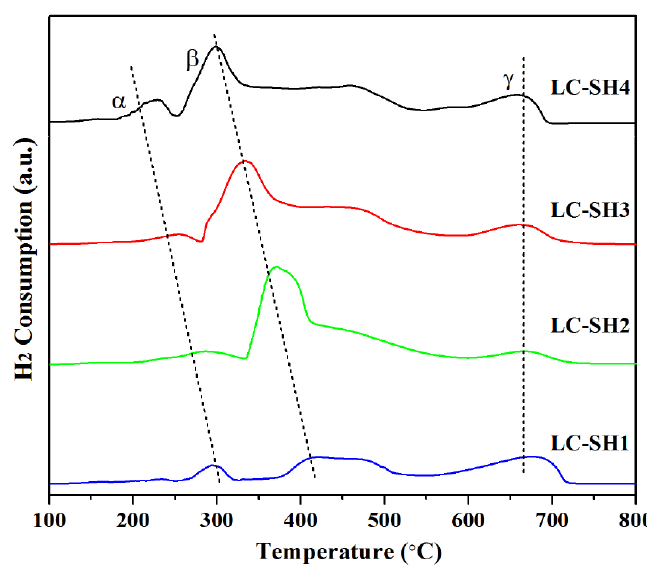
Figure 12. H 2 -TPR figures of catalysts with different amounts of nitrogen sources.